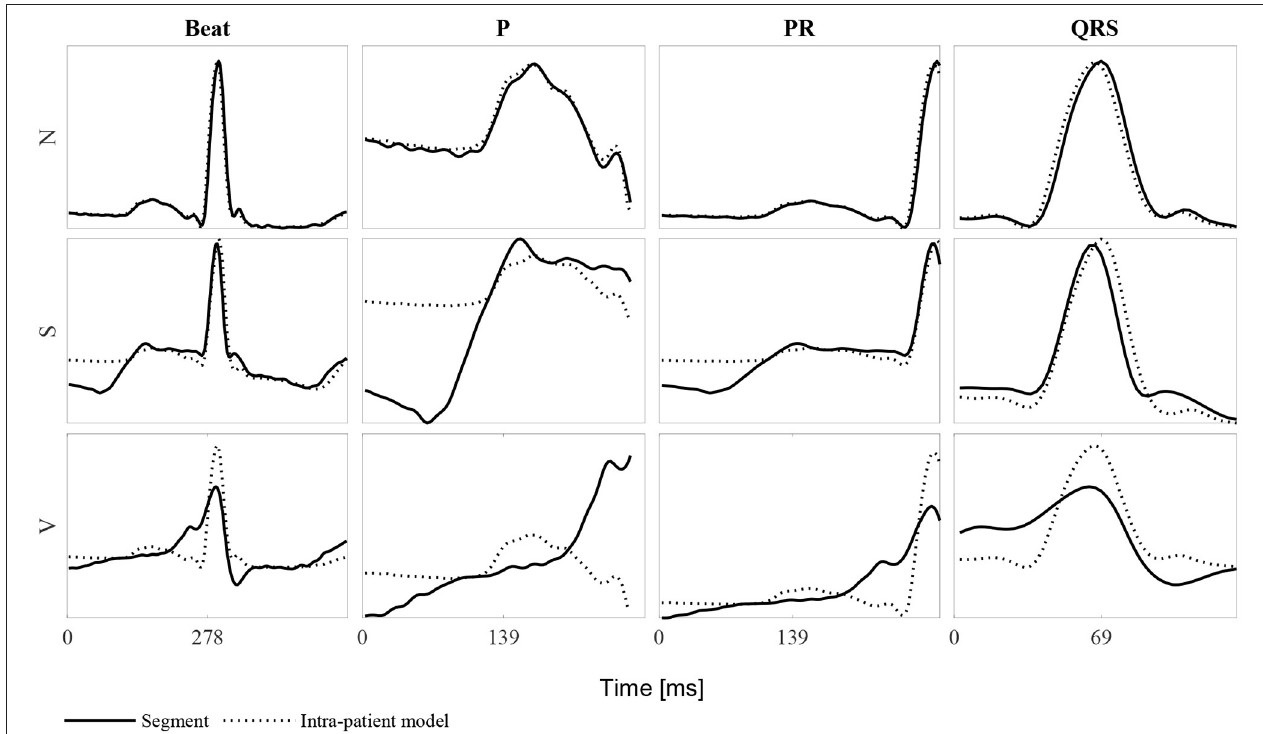
FIGURE 3 | Example of each of the beat classes N , S , and V for the whole beat, the P wave, PR segment and QRS complex. Each row represent one of the three beat types and each column the mentioned ECG segments. Continuous lines represent the beat segment itself whereas dashed lines represent the corresponding intra-patient models built with the 40 beats before and after the beat of study (80-beat intra-patient